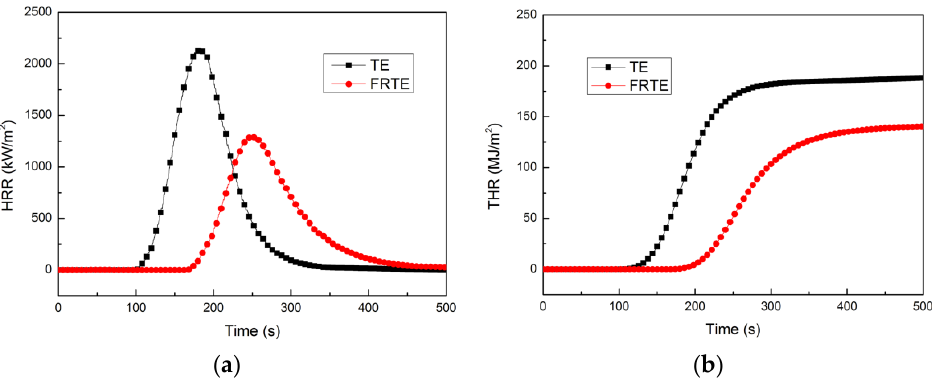
Figure 2. The heat release rate ( a ) and total heat release ( b ) curves for TE composites.